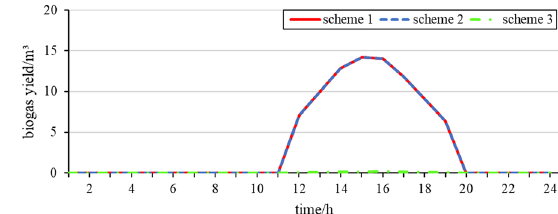
Fig. 19 Biogas yield in winter